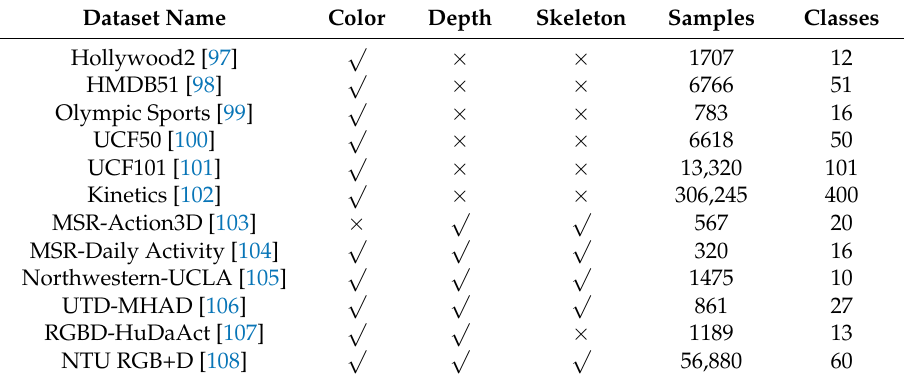
Table 1. The popular dataset of human action recognition.